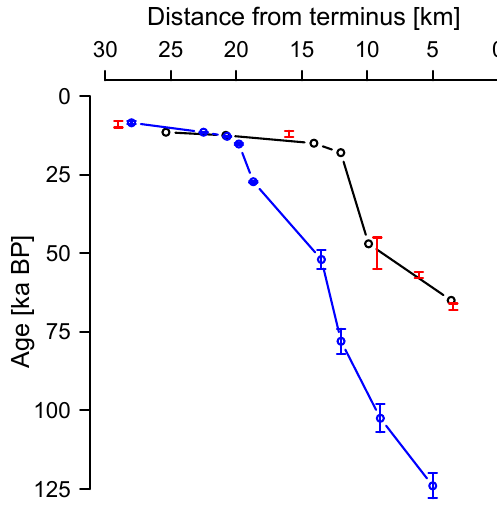
Figure 4. Distance age estimates for the Taylor Glacier ablation zone. (Black) Aciego et al. (2007)’s age model based on matching δ D to Taylor Dome and supported by five δ 18 O atm age estimates (red, from their Fig. 5); 1km was added to Aciego et al. (2007)’s distance scale to account for the fact that their sampling line ended approximately 1km from the glacier terminus. (Blue) Our along- flow profile age model, based on δ 18 O atm and methane concentra- tion. Note that the sampling locations were not identical in both studies and therefore the results are not directly